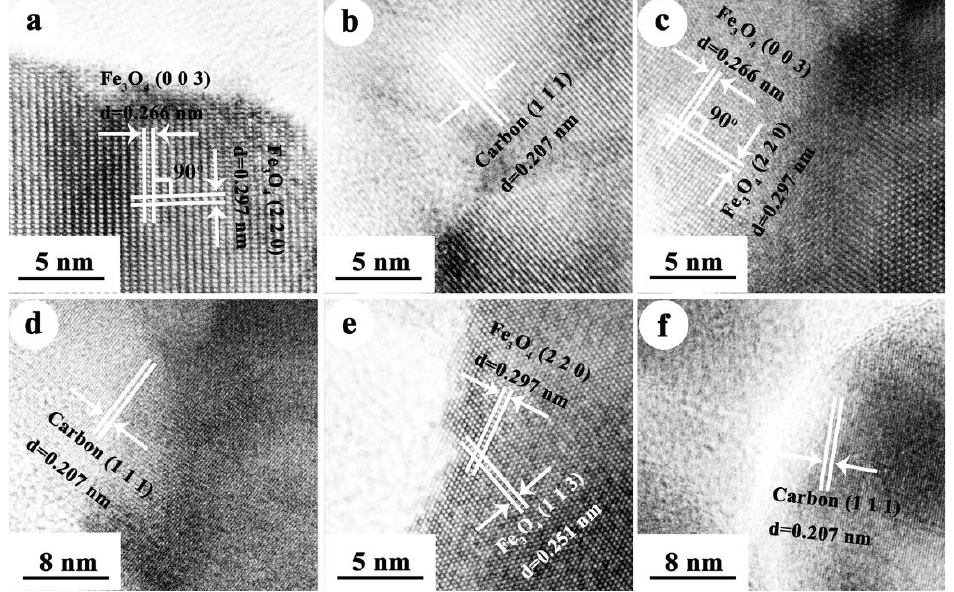
Figure 5. HRTEM images of the C@Fe 3 O 4 composites ( a , b ) nanorod, ( c , d ) nanodisk, and ( e , f ) nanoparticle.